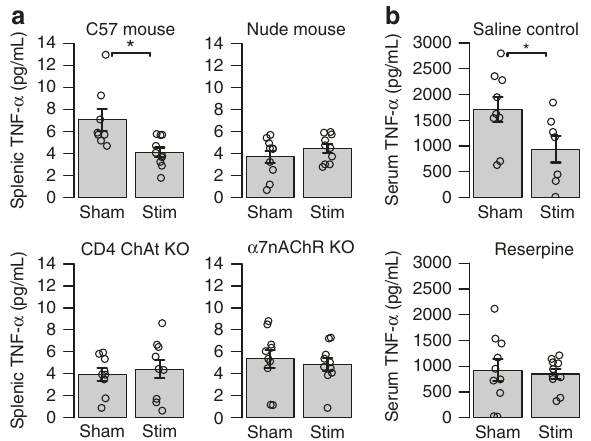
Fig. 4 Splenic U/S stimulation suppresses systemic TNF levels during endotoxemia through CAP. a Splenic concentrations of TNF are shown for sham controls (LPS, -U/S) and U/S stimulated mice (0.83 MPa ultrasound setting) for C57black/6 mice, Nude mice, CD4 ChAT knock-out mice, and α 7nAChR knock-out mice. b Serum TNF concentrations are shown for sham controls (LPS, -U/S) and U/S stimulated mice (0.83 MPa) ultrasound setting for saline injection controls and reserpine treated/denervated (see Methods for details) mice. All experiments in this fi gure were performed using the same U/S settings as in Figs. 2 and 3 (0.83